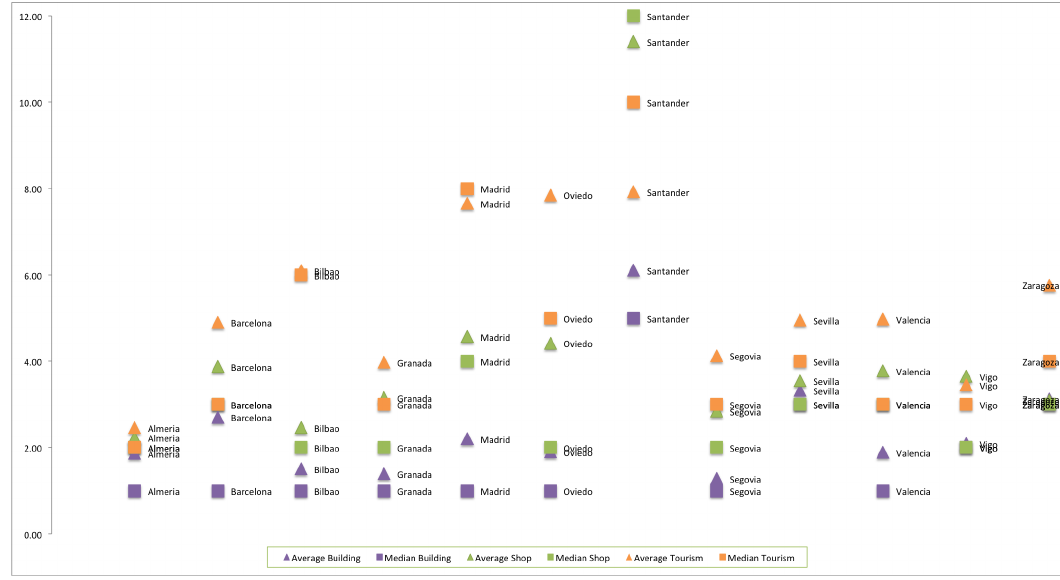
Figure 12. Granularity study in Spain. Average and median of tag number.